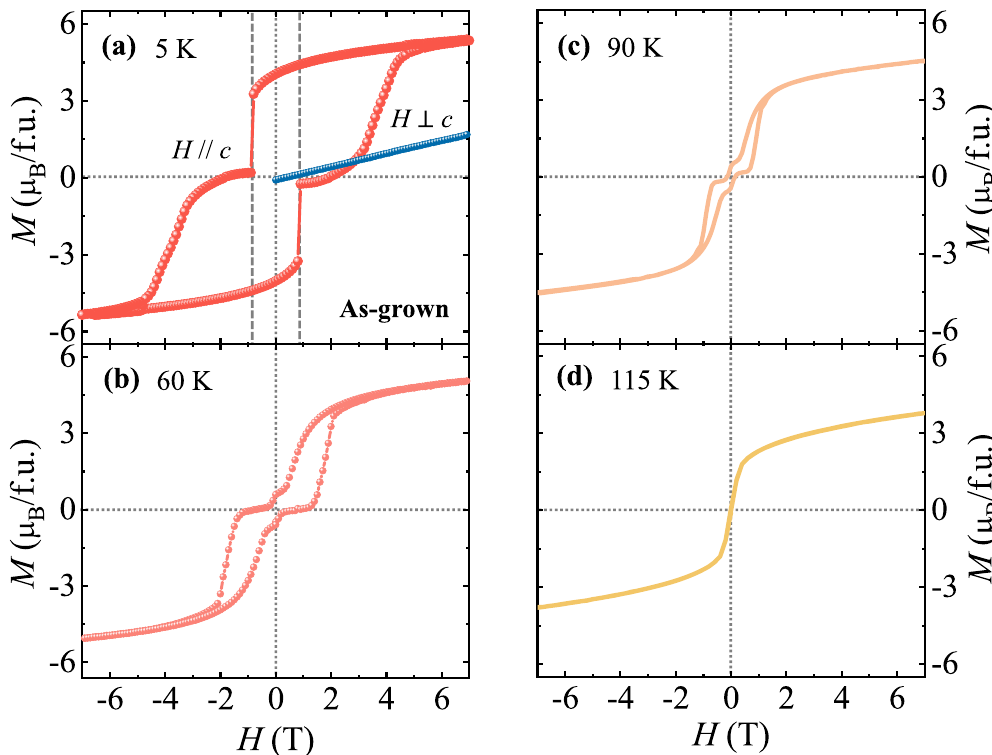
the c axis measured after magnetic-field cooling in 7